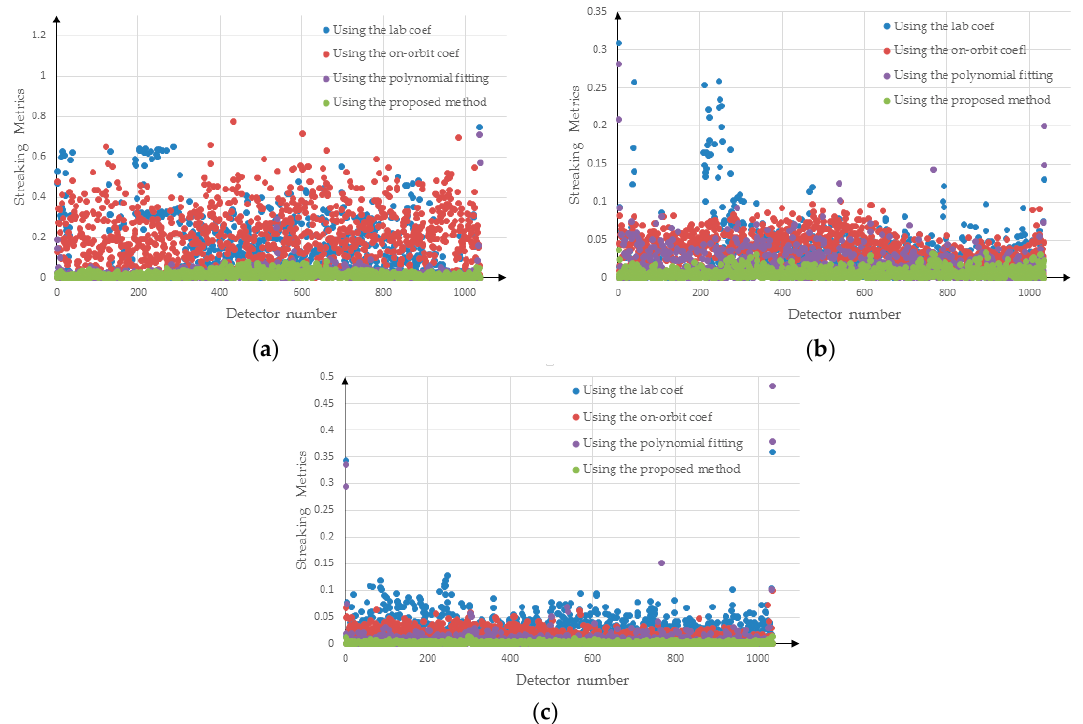
Figure 15. Streaking metrics for the corrected images: ( a ) low-brightness region; ( b ) middle brightness region; ( c ) high-brightness region. Table 2. Comparison of quantitative values for the images.